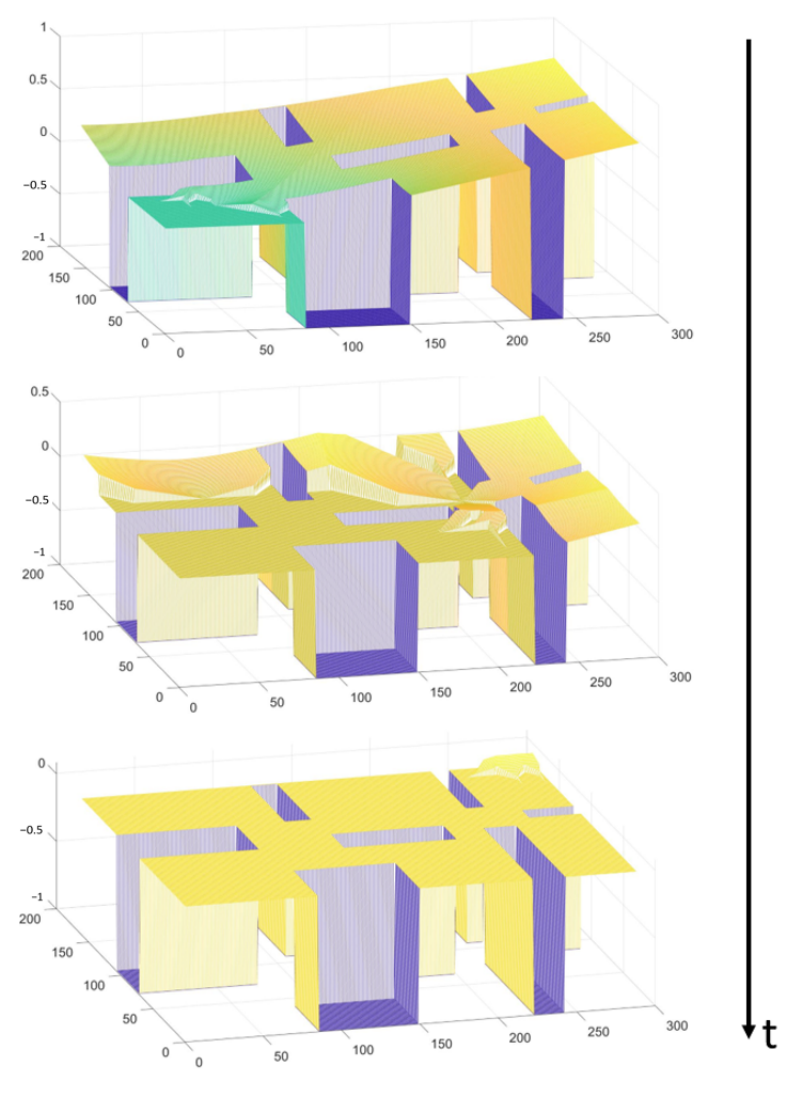
Figure 5. Dynamic evolution of the cost-map during the coverage of Field 4. The negative value − 1 corresponds to neurons occupied by an obstacle. The initial condition is determined as in Figure